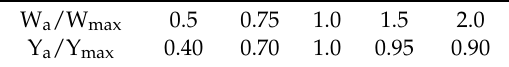
Table 4. Parameters used in the water-yield